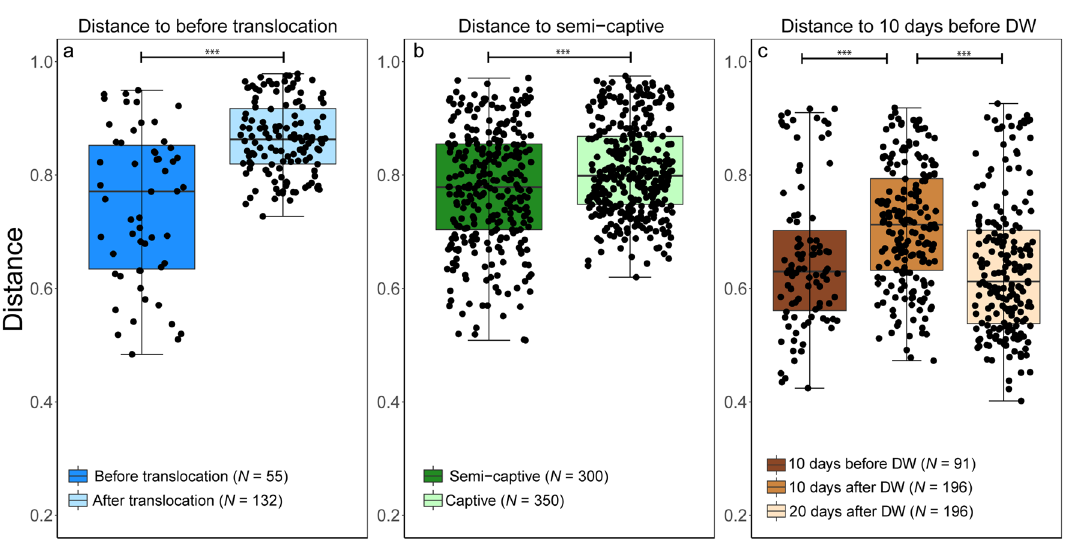
Figure 5. Effect of translocation (a) , captivity (b) and deworming (c) on composition and diversity of the gut microbiome in Asian elephants. Bray–Curtis distances were used to measure the community dissimilarity and analyzed using a pairwise PERMANOVA. *** p <